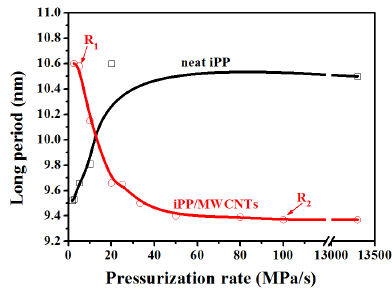
Figure 7. The long period of iPP/MWCNTs and neat iPP samples as a function of pressurization rate.